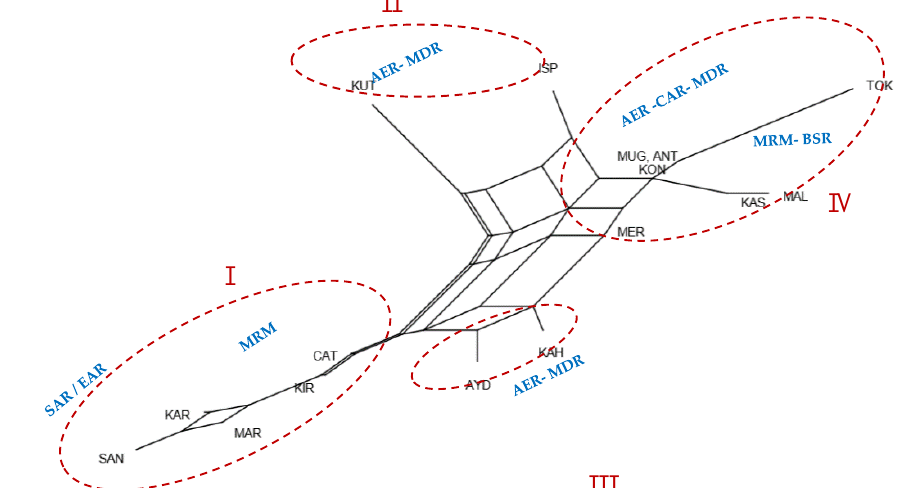
Figure 3. Neighbour-net dendrogram constructed from Reynold’s genetic distances among 16 Turkish donkeypopulation(Kırklareli—KIR, ˙Istanbul / Çatalca—CAT,Malkara—MAL,Amasya /